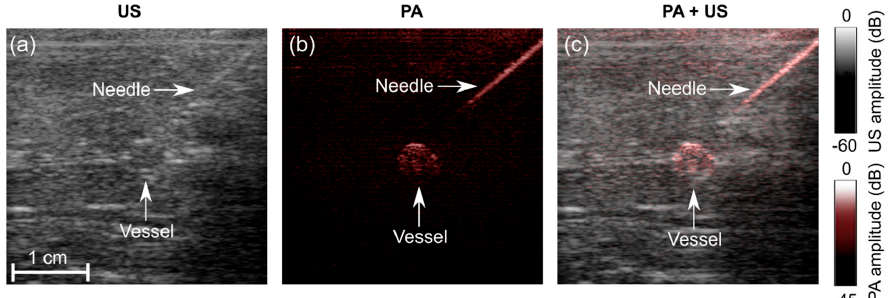
Figure 5. Photoacoustic (PA) and ultrasound (US) imaging of a needle inserted towards a vessel mimicking phantom. ( a ) US image; ( b ) PA image at 850 nm; ( c ) PA + US image overlay. During the insertions, these images were reconstructed and displayed in real-time on a logarithmic scale. Here, they are presented without the uppermost 5 mm, which contained the ultrasound gel. A video is provided in Supplementary Materials (Video S1).